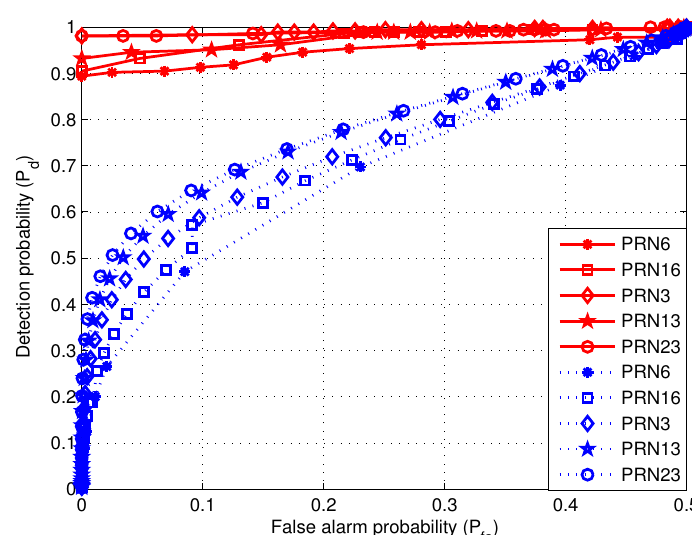
Figure 11. The relationship between detection probability and false alarm probability for the first 294 s data. The red solid and blue dashed curves are separately corresponding to the proposed algorithm and the ratio